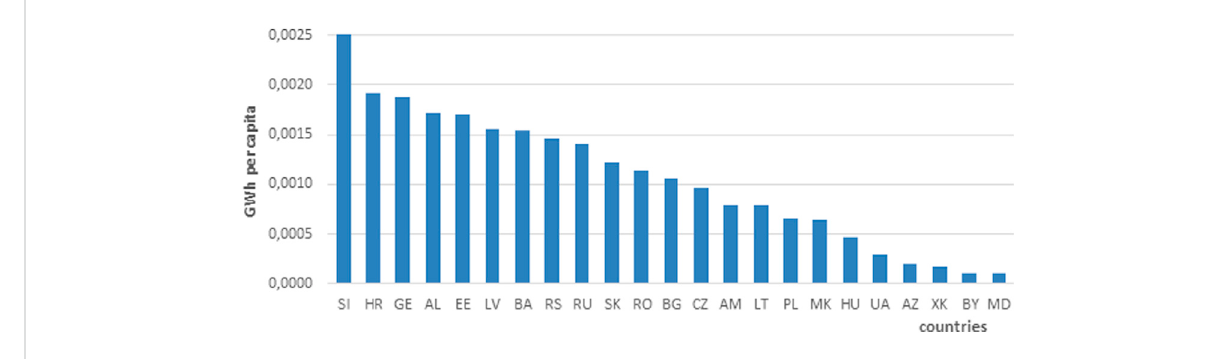
FIGURE 3 Production of energy from renewable sources per capita in countries of Central and Eastern Europe in 2019.